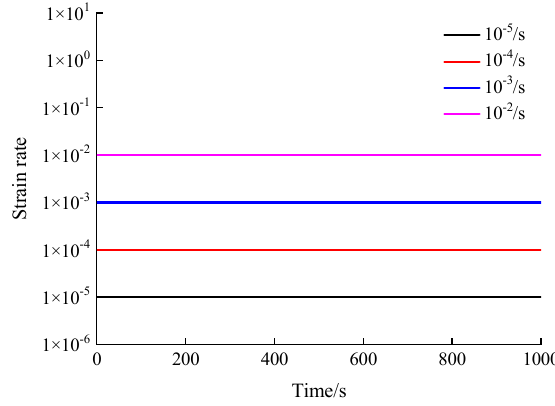
Figure 3. Schematic plot showing loading strain rates over time.